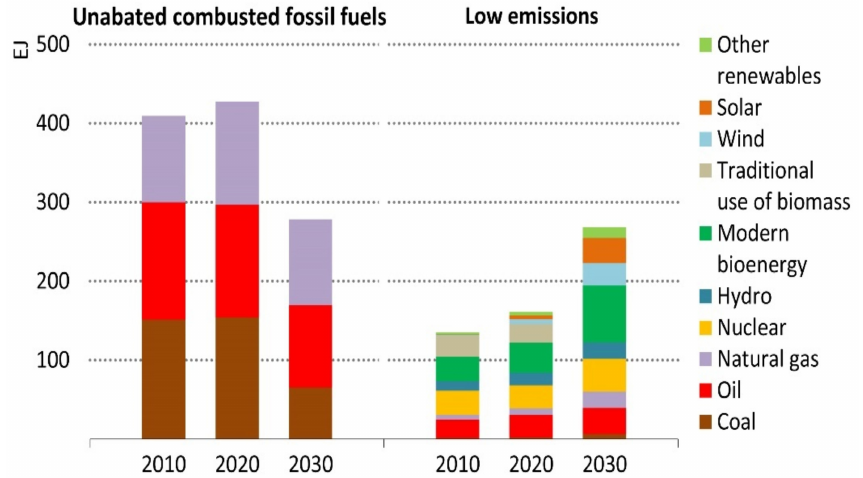
Figure 1. Transition in global total supplied energy by different sources (Energy and Iea, 2021